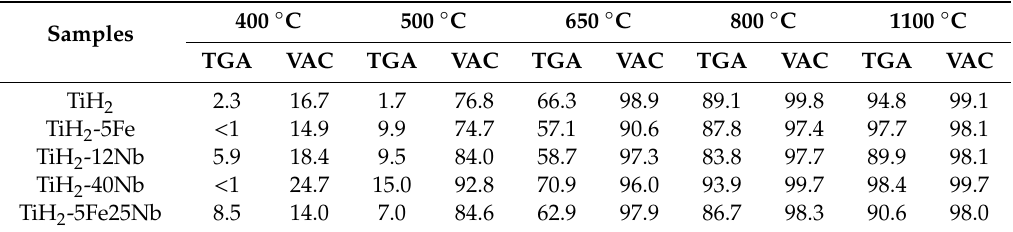
Table 3. Relative hydrogen weight loss (%) for treated samples heated in Thermogravimetric analysis (TGA) and Vacuum treatments (VAC)